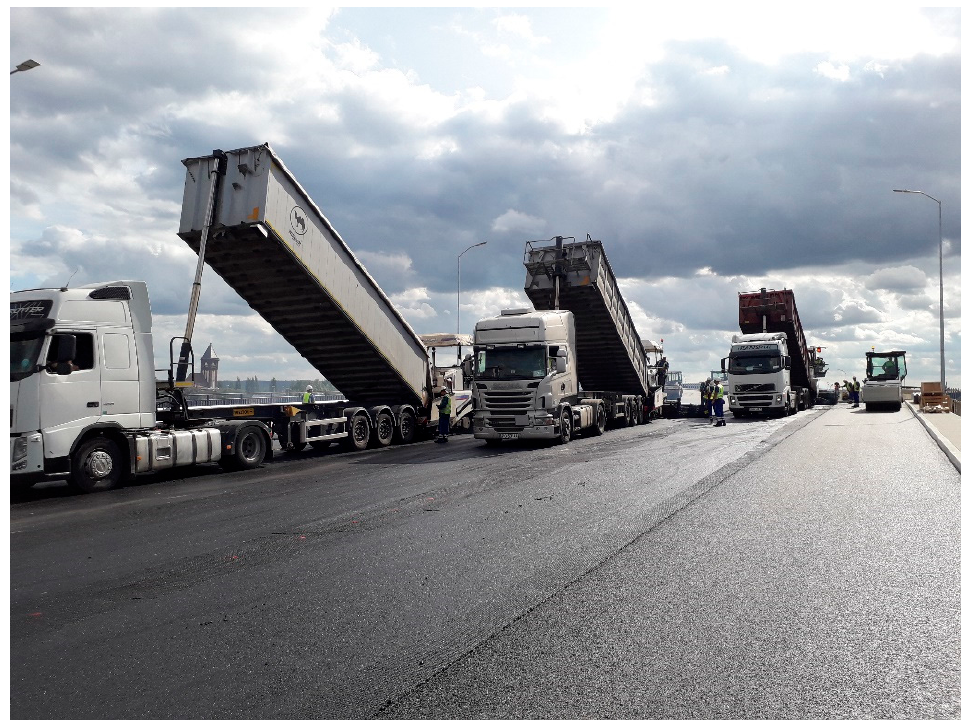
Figure 18. Placement of wearing course of SMA 11 PMB 45/80-65 mixture.